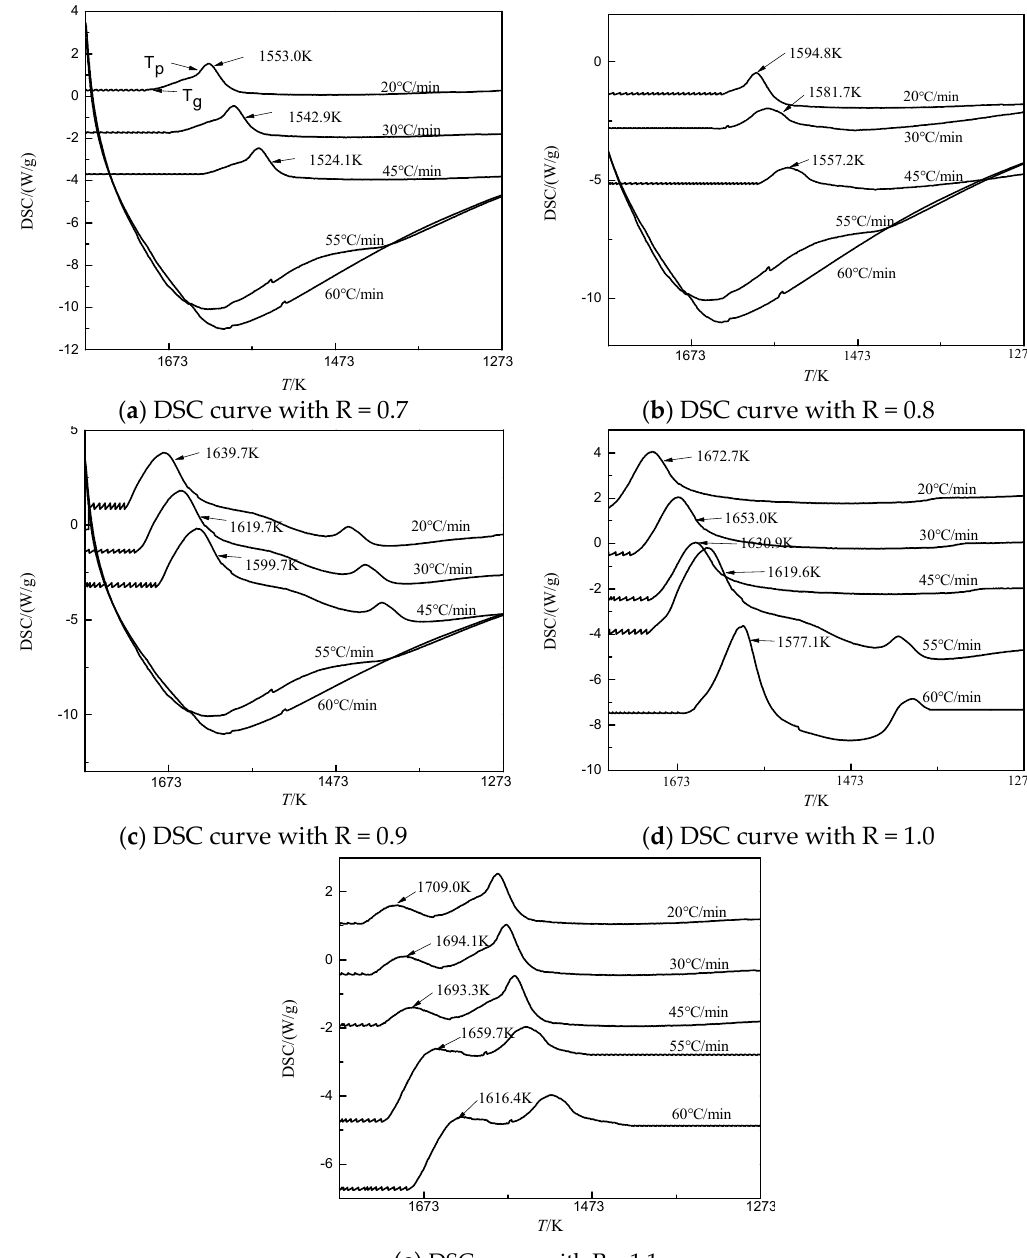
Figure 6. DSC curves of BFS at different basicities: ( a ) R = 0.7; ( b ) R = 0.8; ( c ) R = 0.9; ( d ) R = 1.0; ( e ) R = 1.1.